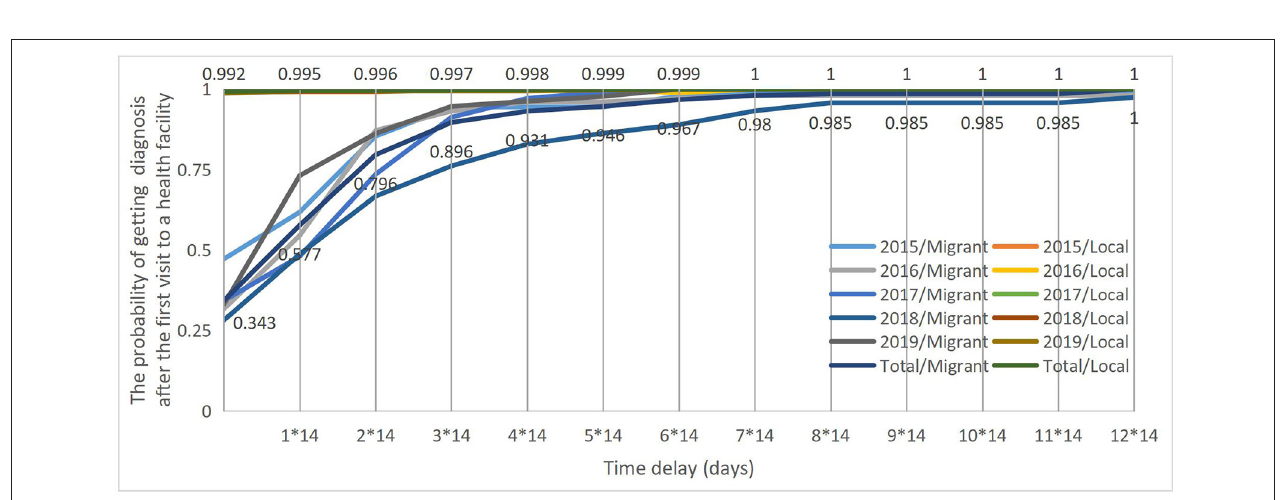
FIGURE 2 | Patient delay curves between migrant and local patients with TB from 2015 to 2019.